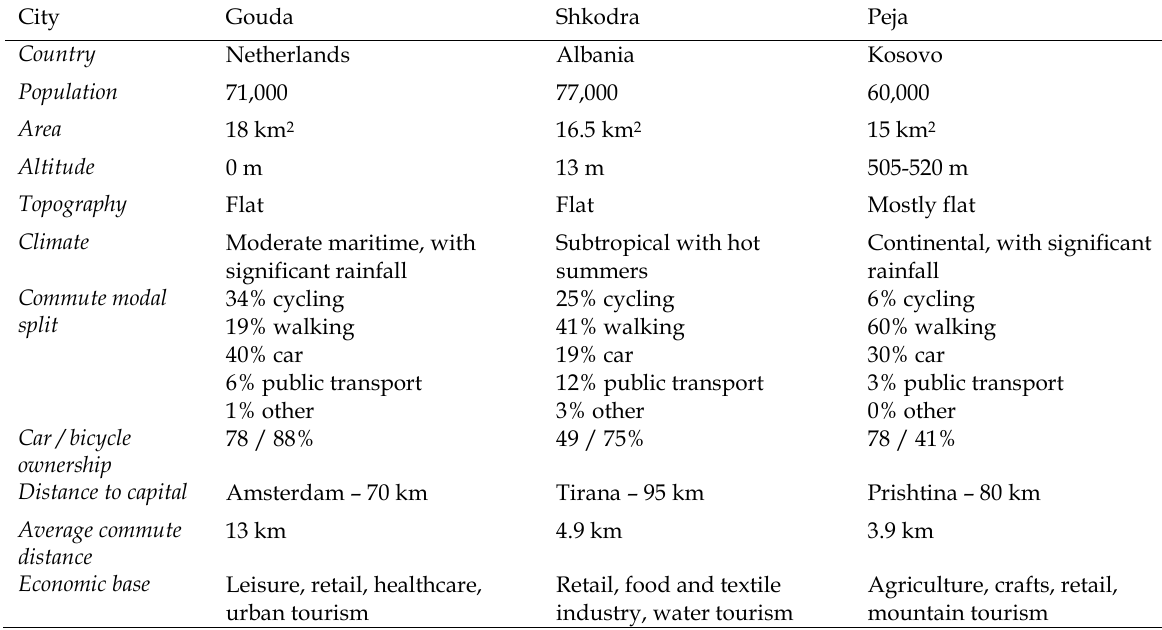
Sources: Data on mobility in Peja and Shkodra were provided by MobKos and MobAlb respectively. All other data are courtesy of the respective municipal